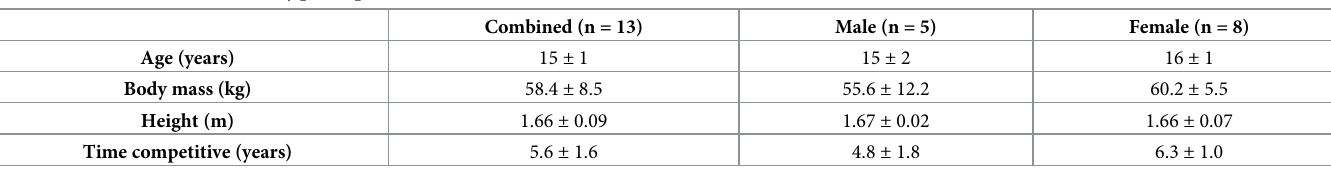
Table 1. Characteristics of the study